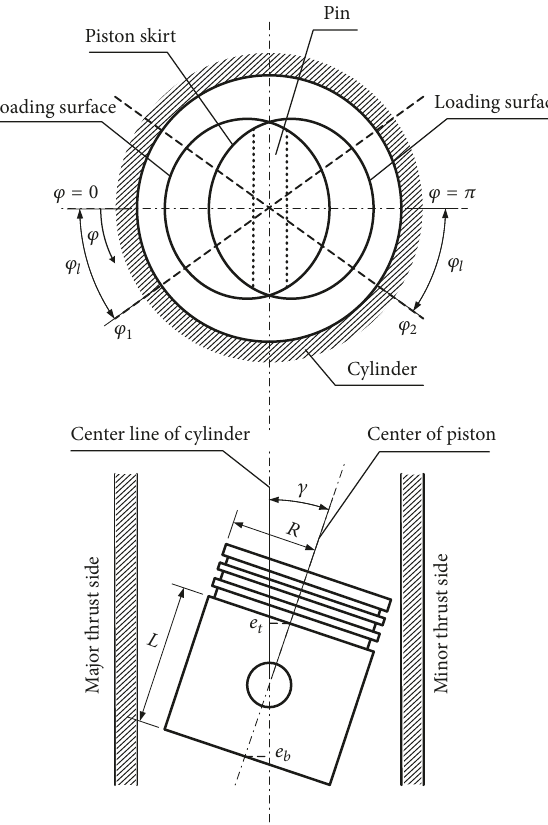
Figure 2: Schematic diagram of the piston-cylinder